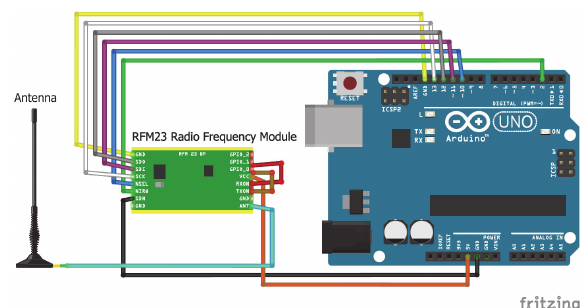
Figure 5: Scheme of tag